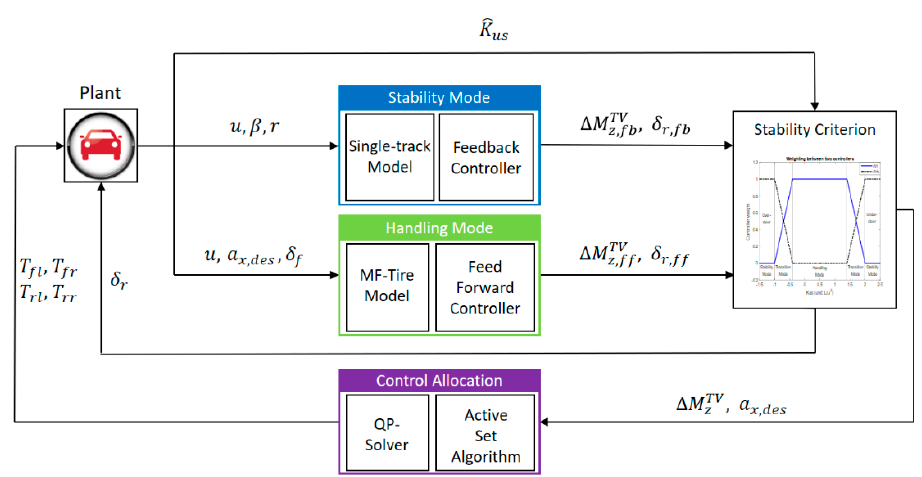
Figure 6. Block diagram of the overall control system.